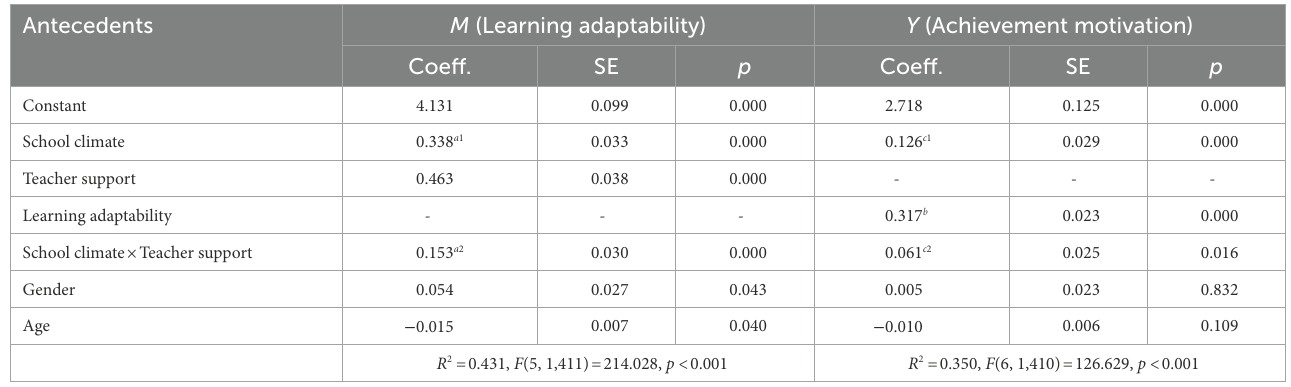
TABLE 2 Model coefficients for conditional process